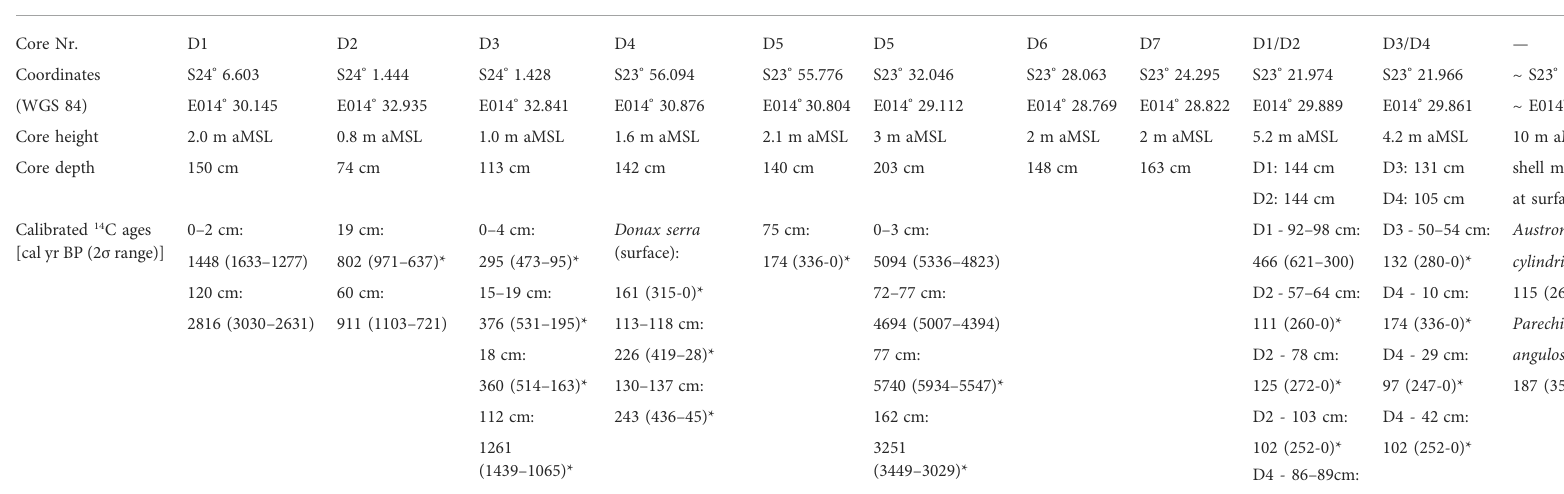
TABLE 1 Characteristics of the studied (paleo-)lagoons and drilling sites along the Namibian coast. Lagoon/pan Conception Bay Sandwich Bay Shell midden Core